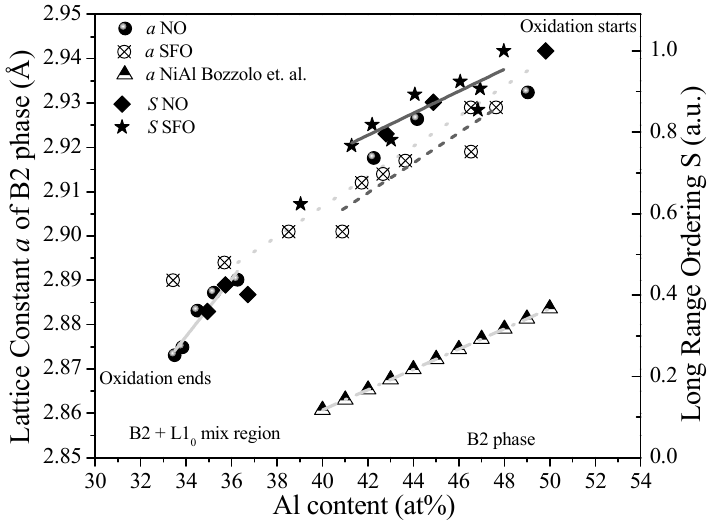
Figure 6. Variation of lattice constant as a function of Al content for NO and SFO experiments. Results of the analysis from a Binary (Bozzolo) and commercial systems are